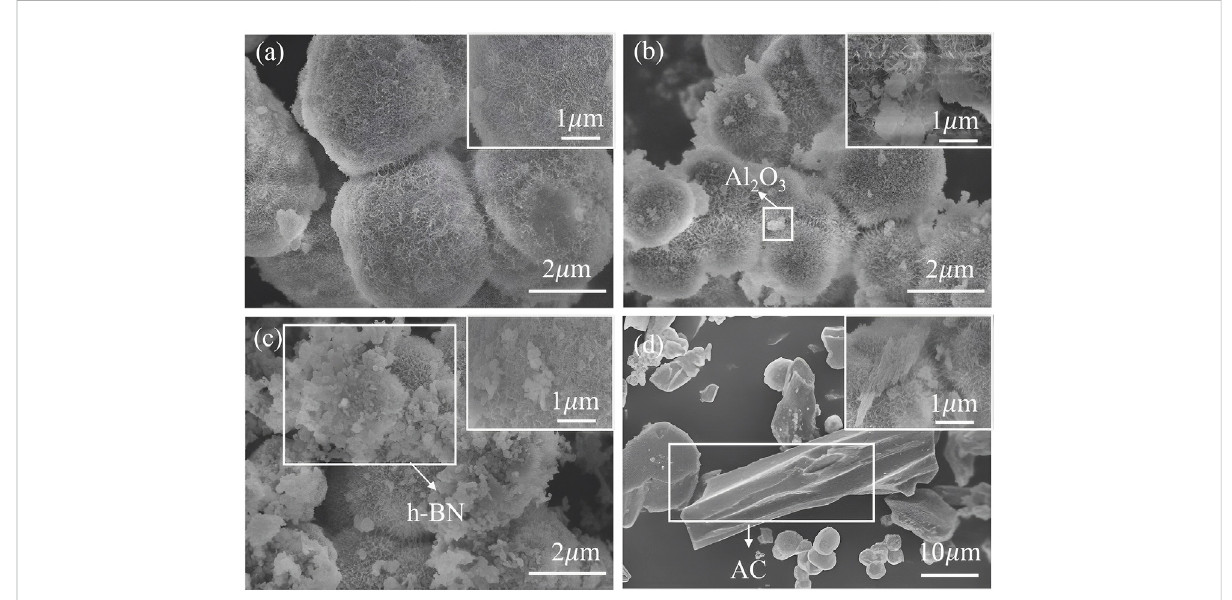
FIGURE 3 SEM results for (A) α -Ni(OH) 2 , (B) α -Ni(OH) 2 /nano-Al 2 O 3 , (C) α -Ni(OH) 2 /h-BN, and (D) α -Ni(OH) 2 /AC.